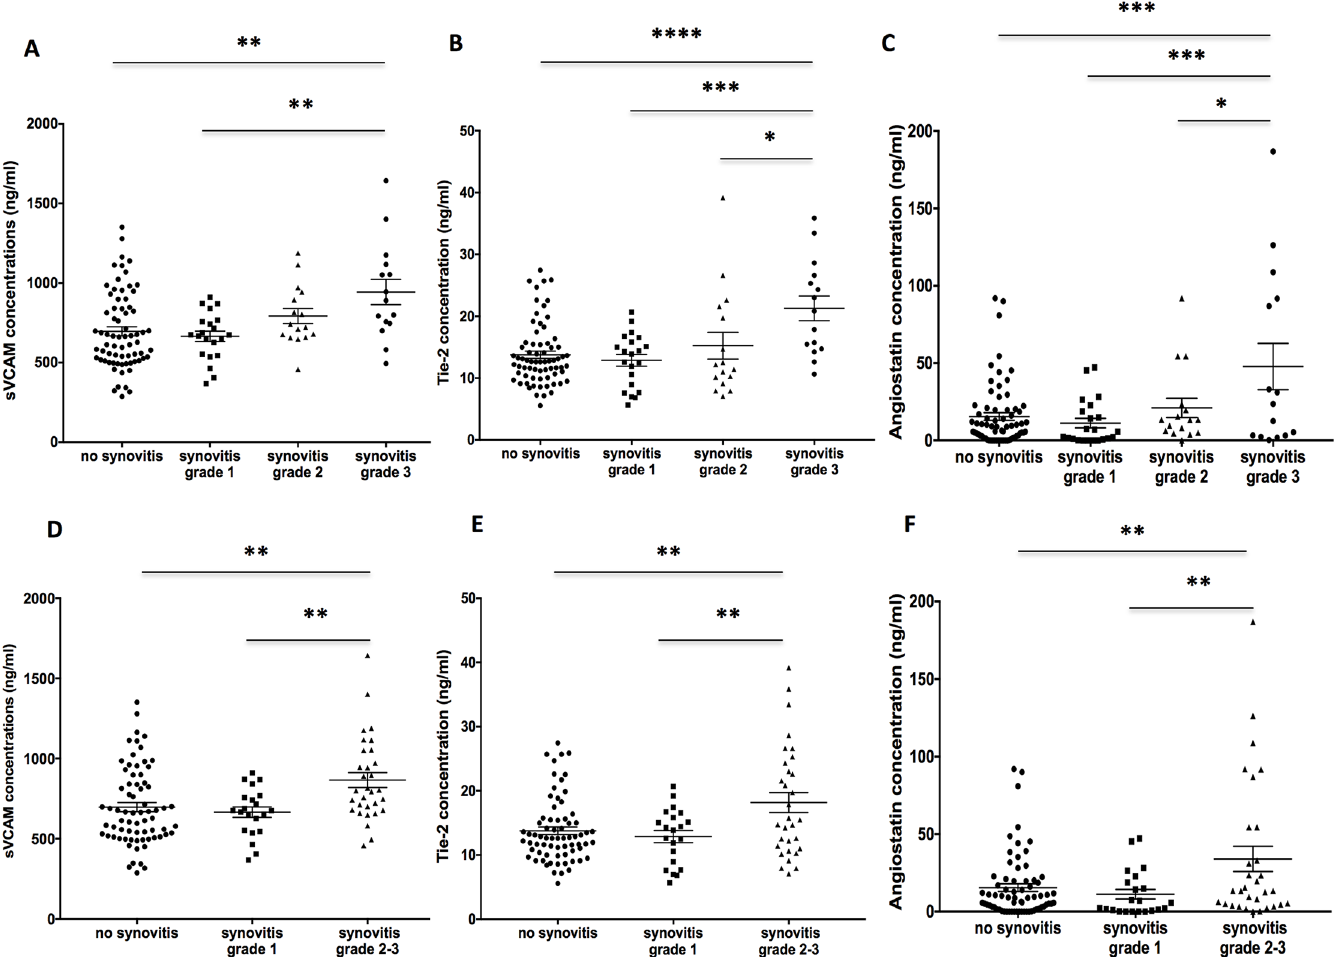
Fig 2. Levels of sVCAM-1 (A and D), Tie-2 (B and E) and Angiostatin (C and F) according to the intensity and extent of synovial vascularization assessed by Power Doppler Ultrasound. Statistical test: ANOVA followed by Tuckey’s multiple comparisons test. (cid:3) P < 0.05, (cid:3)(cid:3) P < 0.01, (cid:3)(cid:3)(cid:3) P < 0.001, (cid:3)(cid:3)(cid:3)(cid:3) P <